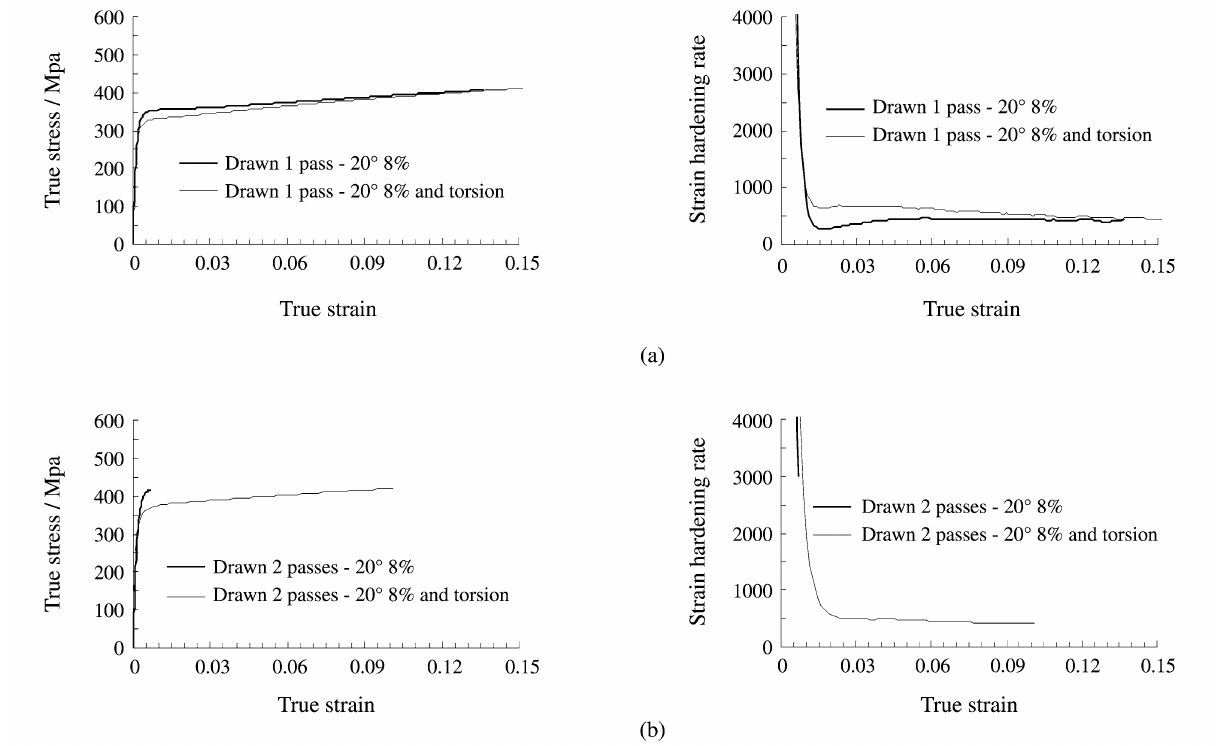
Figure 3. Effect of cyclic torsion on the hardening behavior of drawn (semi-angle 8° and reduction in area of 20%) samples: (a) 1 pass and (b) 2